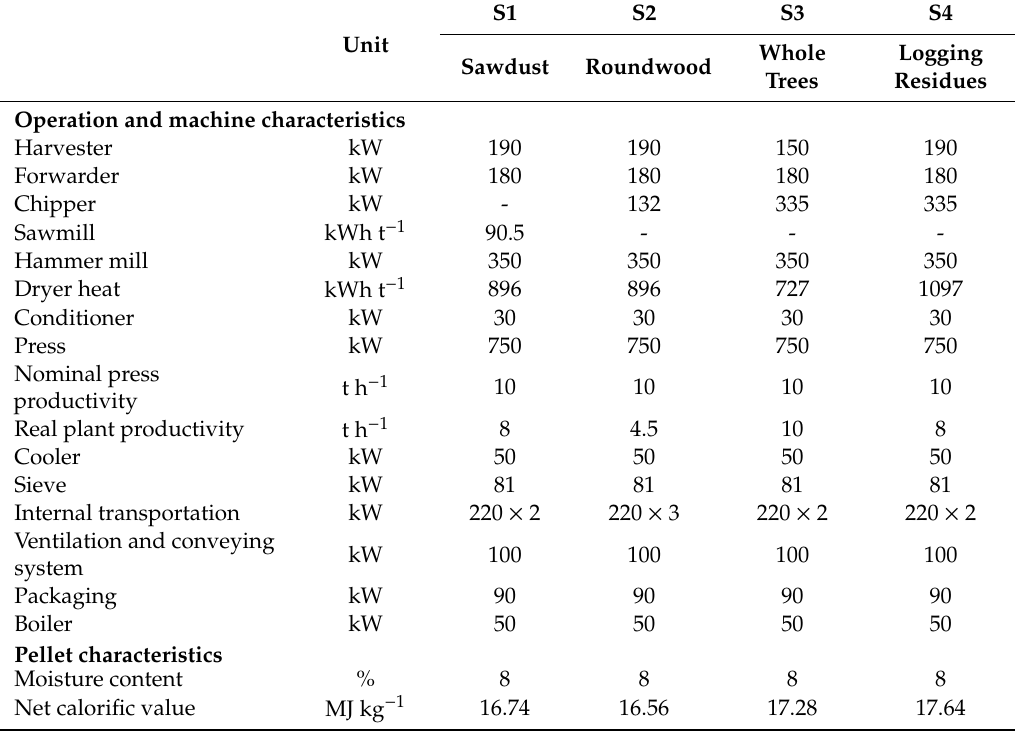
Table 1. Characterization of the machines and equipment involved in each scenario, as well as the main characteristics of the pellets produced from di ff erent wood feedstocks (S1: pellets produced from sawmill sawdust; S2: pellets produced from roundwood logs; S3: pellets produced from whole trees; S4: pellets produced from logging